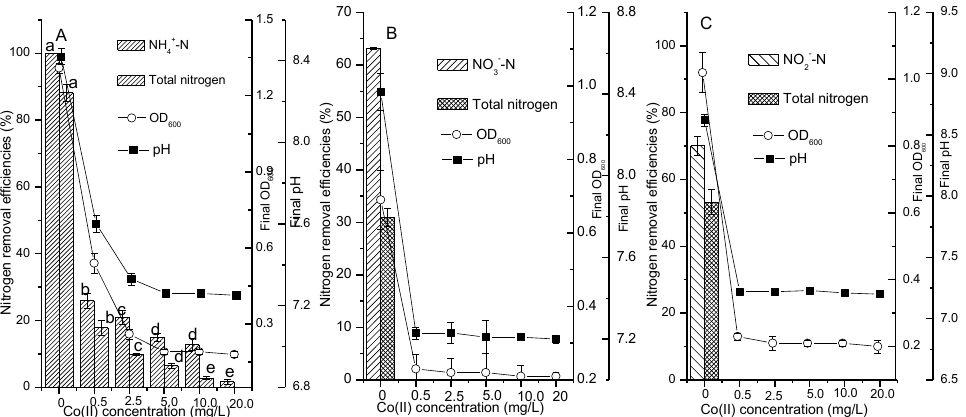
Figure 2. Effects of Co(II) on ammonium, nitrate, and nitrite removal abilities of strain Y-10. ( A ) ammonium; ( B ) nitrate; ( C ) nitrite. The values shown are the means ± the SD of the results of three replicates (error bars). Different letters indicate a significant difference between treatments at p < 0.05.